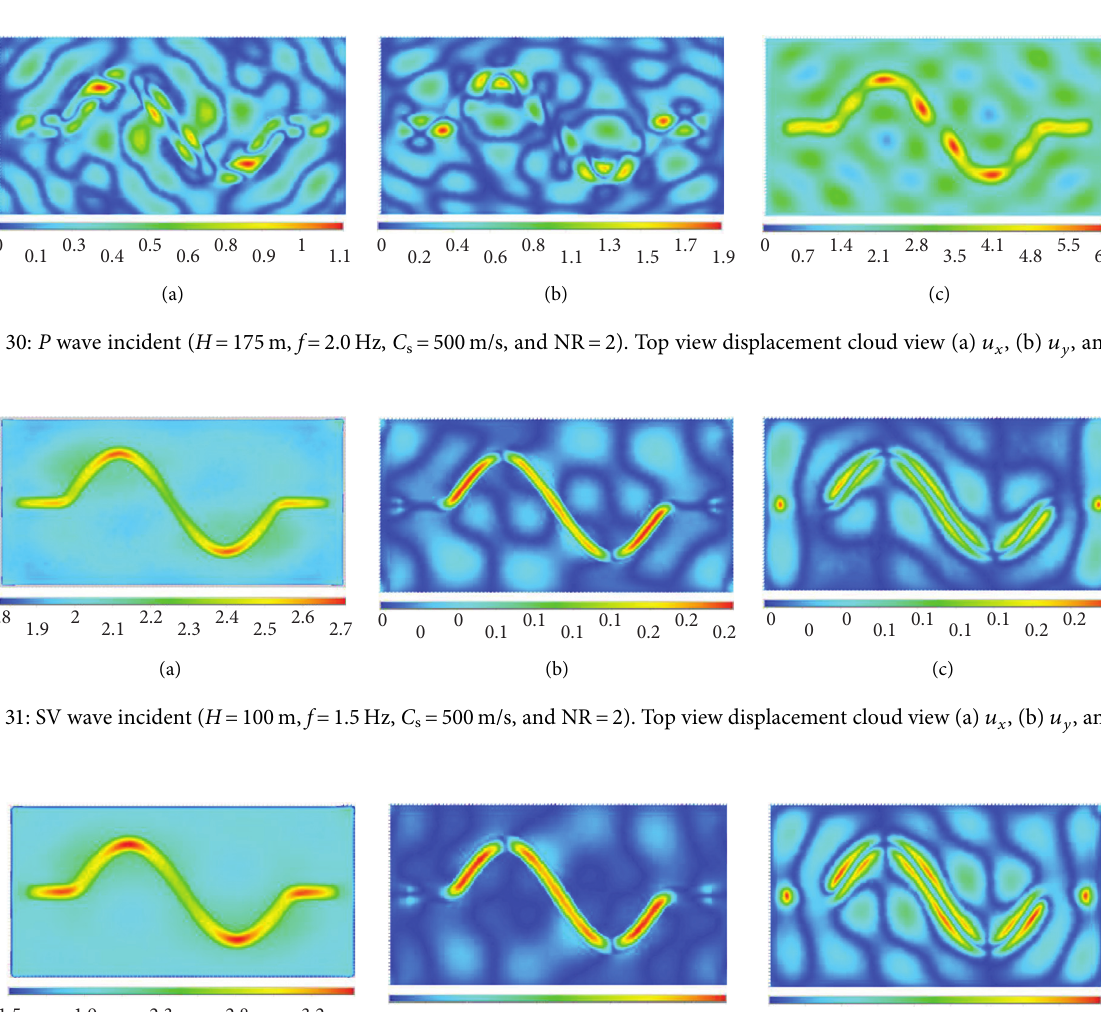
� 500 m/s, and NR � 2). Top view displacement cloud view (a) u s